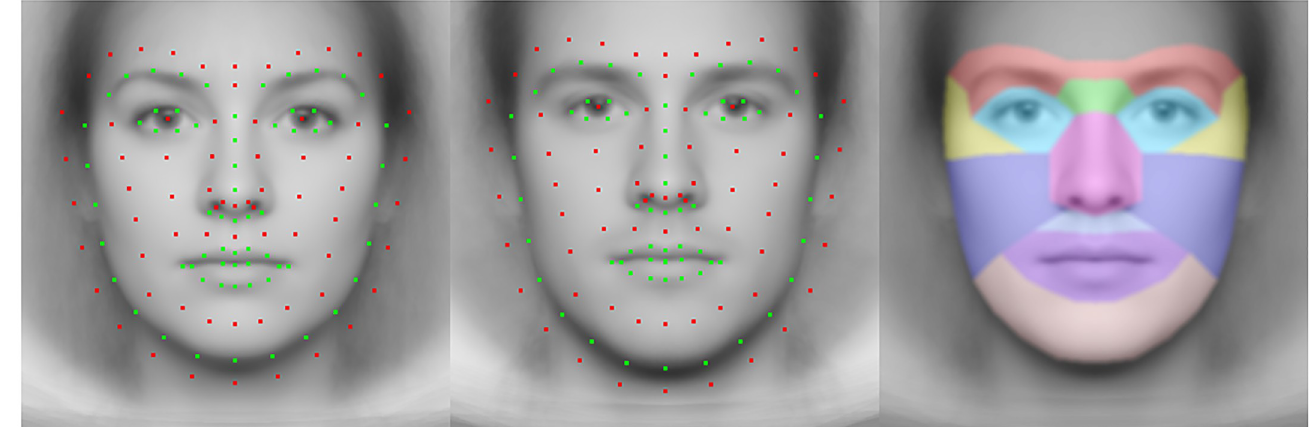
Fig 5. Left and middle panels : Average of the 132 facial landmarks on the morphs of all female and male faces from the Oslo Face Database. The green points are the landmarks defined by the Dlib-library, and the red points are the added landmarks. The outermost red points help to avoid distortions near the outline of the face following image warping. Right panel : The regions (in color) used to calculate the percent dwell times on facial parts are shown superimposed on the androgynous face morph of all faces from the Oslo Face Database.